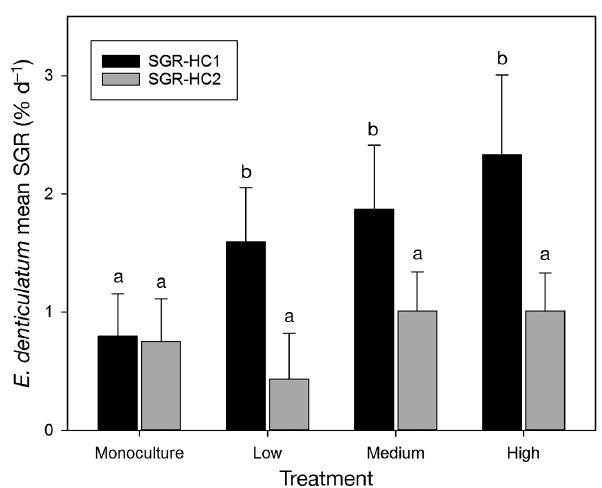
Fig. 2. Specific growth rate (SGR, mean ± SD) of Eucheuma denticulatum grown without sea cucumbers (monoculture) and at low, medium and high stocking densities of sea cu- cumbers Holothuria scabra during December 2013 and March 2014 in both harvest cycle 1 (SGR-HC1) and harvest cycle 2 (SGR-HC2) of the study. Letters indicate results of Tukey’s HSD post-hoc test. Values with different letters are significantly different from each other at p < 0.05